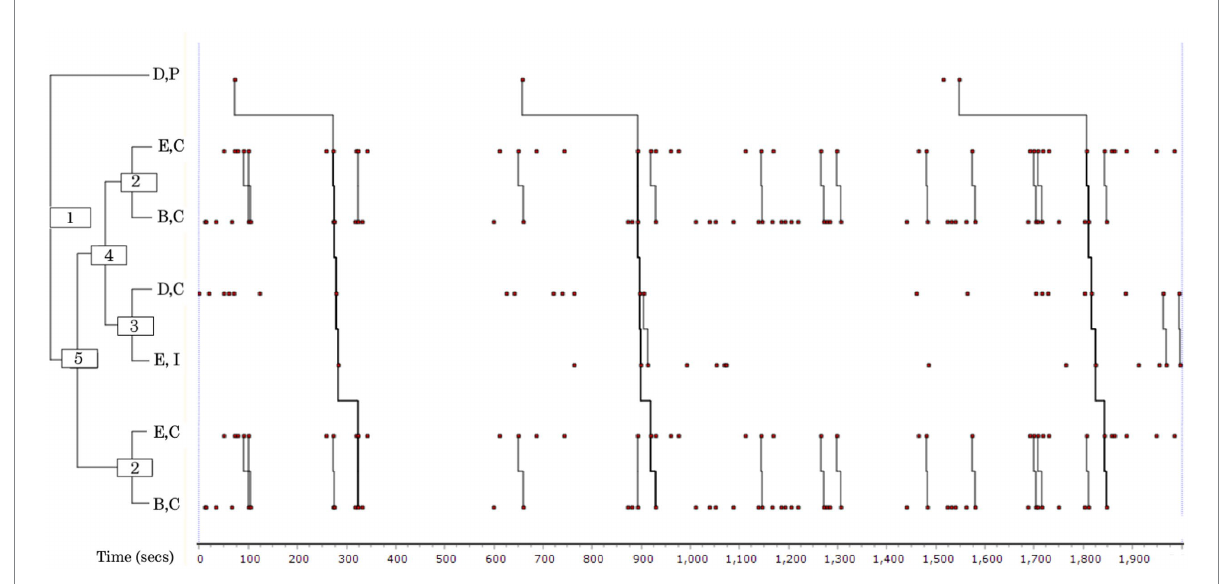
FIGURE 1 Pattern diagram (dendrogram) output from THEME ® analysis showing main patterns and frequent sub patterns (Group 1, Week 3). Three members of the ensemble featured in the patterns; interactions were a mixture of light-hearted and more task-focussed discussions of technical aspects, such as choice of speed, expression, or repertoire. The first event in all long patterns was a humorous contribution from Singer D (1), followed by dyadic interactions between Singers E and B (2), and between D and E (3), which appear in combination (4) and in the main pattern (5).